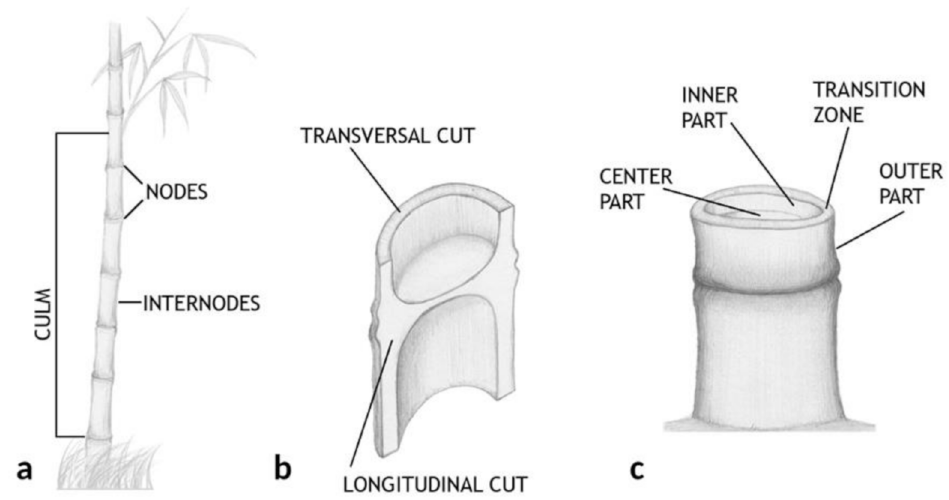
Figure 1. Bamboo scheme: ( a ) view of the plant from the ground to the beginning of the branches, ( b ) longitudinal and transverse sectioned view and ( c ) circular cross